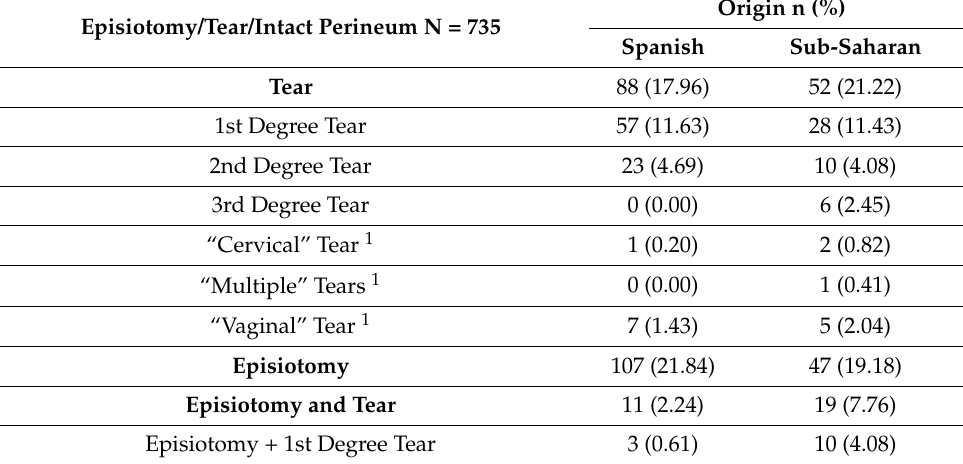
Table 5. The variable episiotomy/tear/intact perineum according to